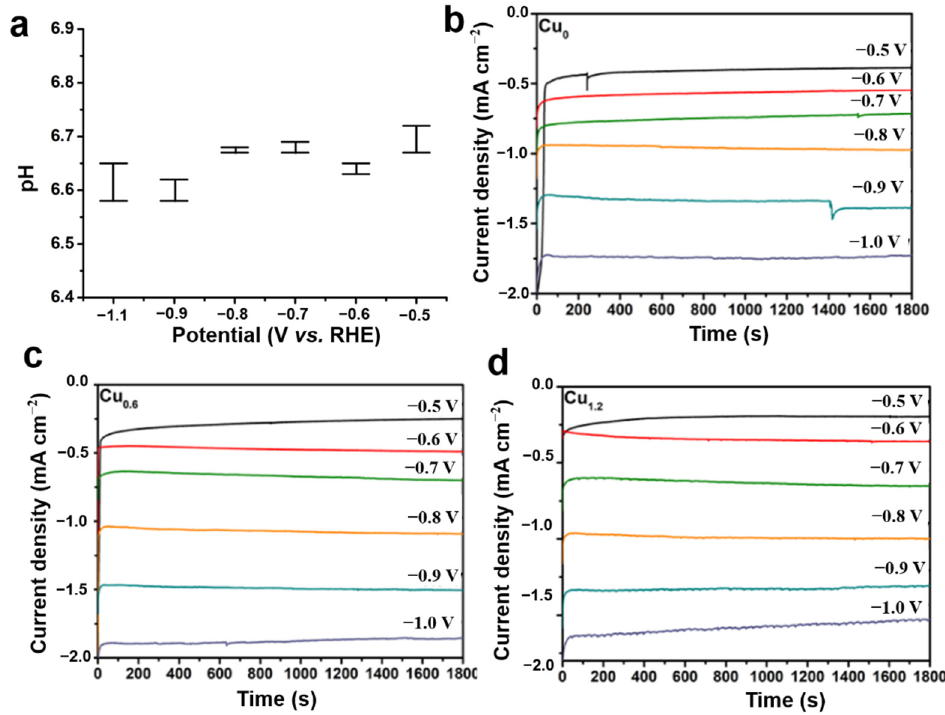
Figure 10. pH changes for Cu 0.6 before and after the CO 2 RR ( a ), the standard deviation no more than 0.02. Current densities for ( b ) Cu 0 , ( c ) Cu 0.6 and ( d ) Cu 1.2 during CO 2 RR.